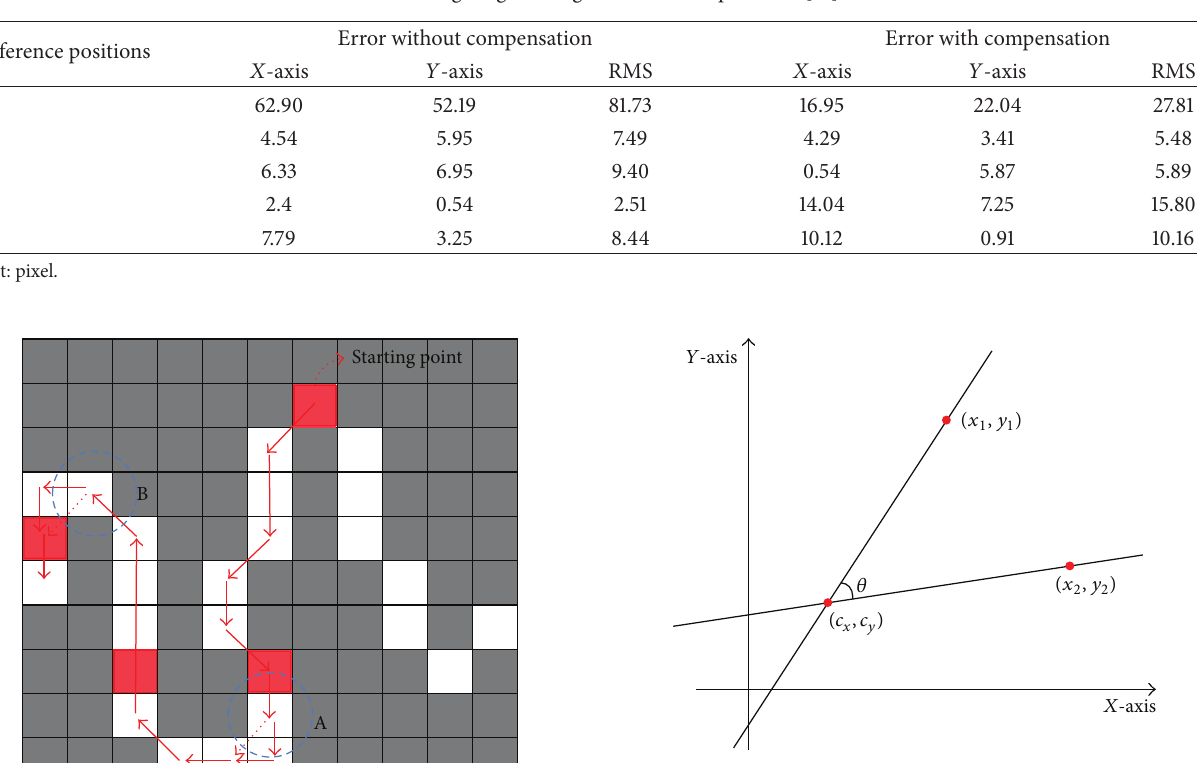
Figure 7: (a) 8-neighbor pixels and (b) assigned priority of the 8-neighbor pixels. Table 1: Targeting error against reference positions [10].